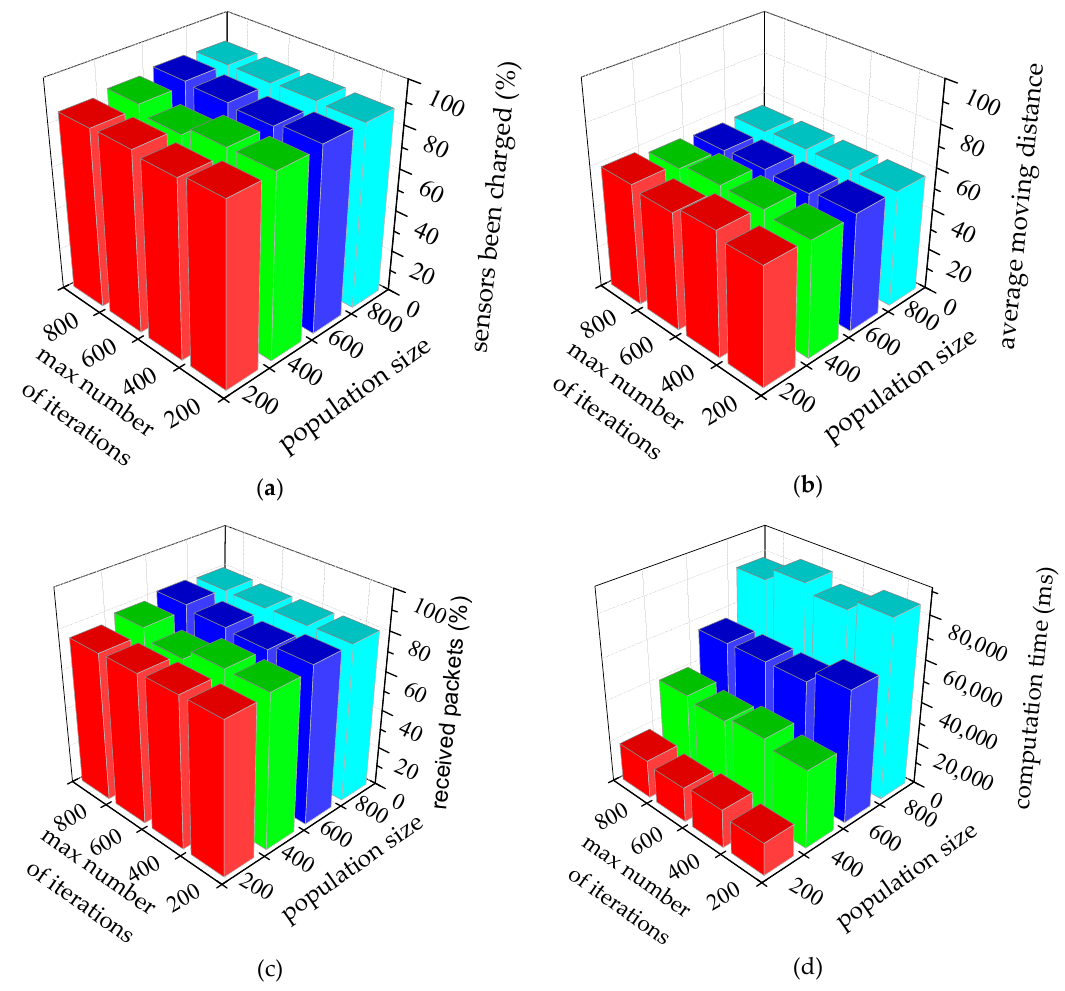
Figure 6. The performance metrics of the proposed genetic algorithm when varying population sizes and maximal number of iterations. ( a ) percentage of sensors been charged, ( b ) average moving distance, and ( c ) percentage of packets received, and ( d ) average computation time, vs population sizes and maximal number of iterations. Note that simulation time and network traffic are set at 10,000 s and [0, 100/ n ], while the other parameters, except population size and maximum number of iterations, are the same as shown in Table 2.